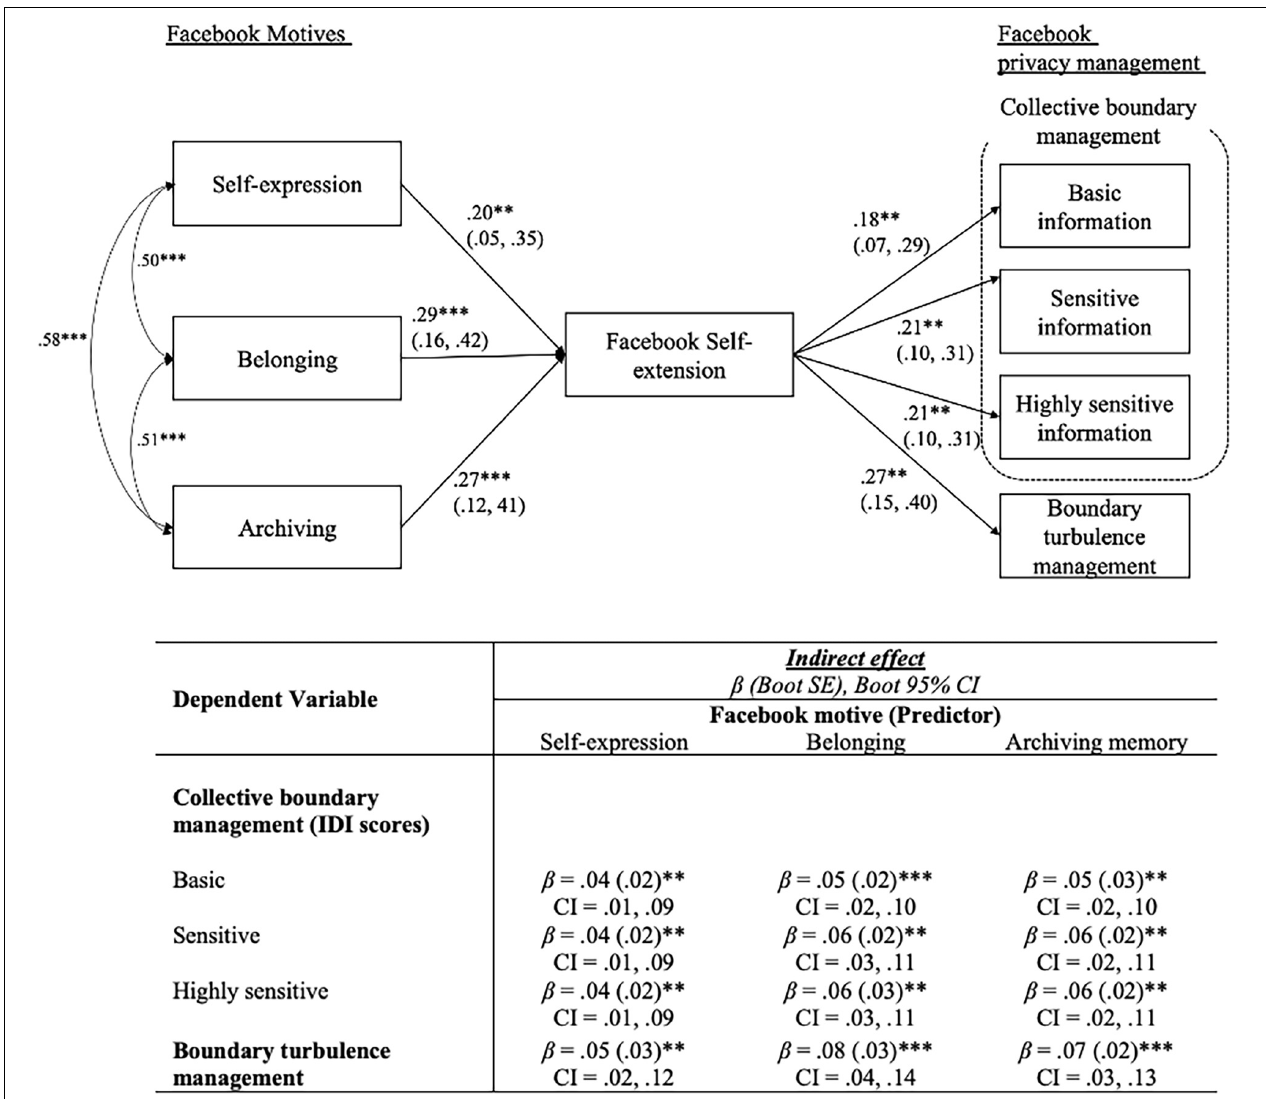
FIGURE 1 | Path analysis results. Goodness of Fit: x 2 = 14.8, df = 12; CFI = 0.998, TLI = 0.987, AGFI = 0.940, RMSEA = 0.028 (90% CI:0.00, 0.07); Path entries are standardized coefficient ( β ) and 95% CI; ∗ p < 0.05; ∗∗ p < 0.01; ∗∗∗ p < 0.001; gender, age, education, poweruse, # of friends, frequency of usage were included in the model as control variables.